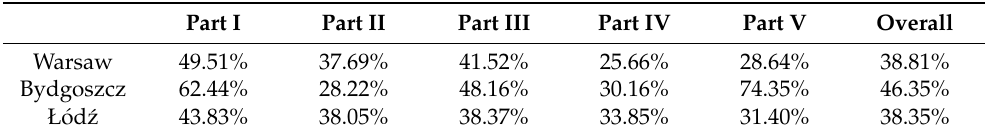
Table 1. Average exam results in particular